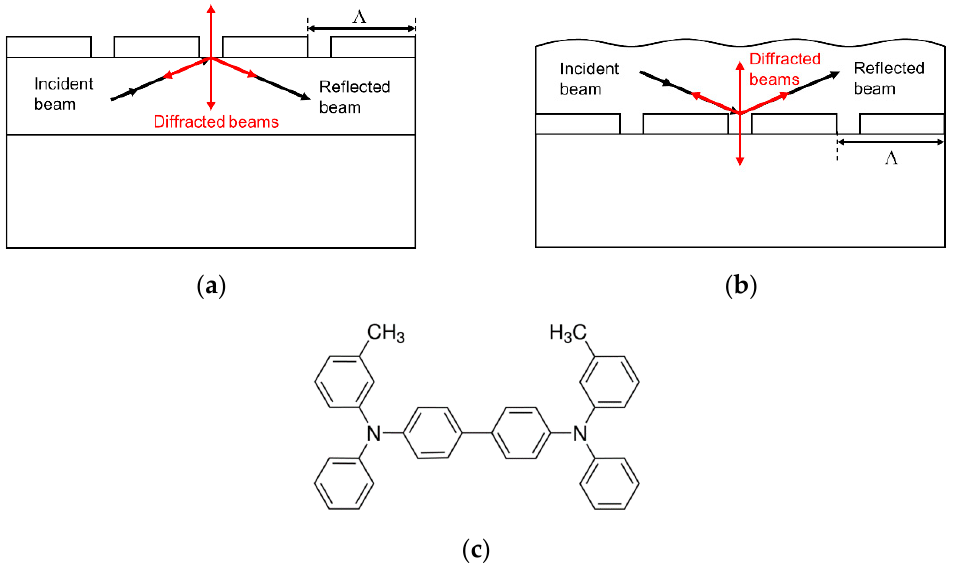
Figure 1. Scheme of a DFB laser with the DCG resonator located: ( a ) on top (RT), and ( b ) below (RB) the active film. The chemical structure of TPD is depicted in ( c ).